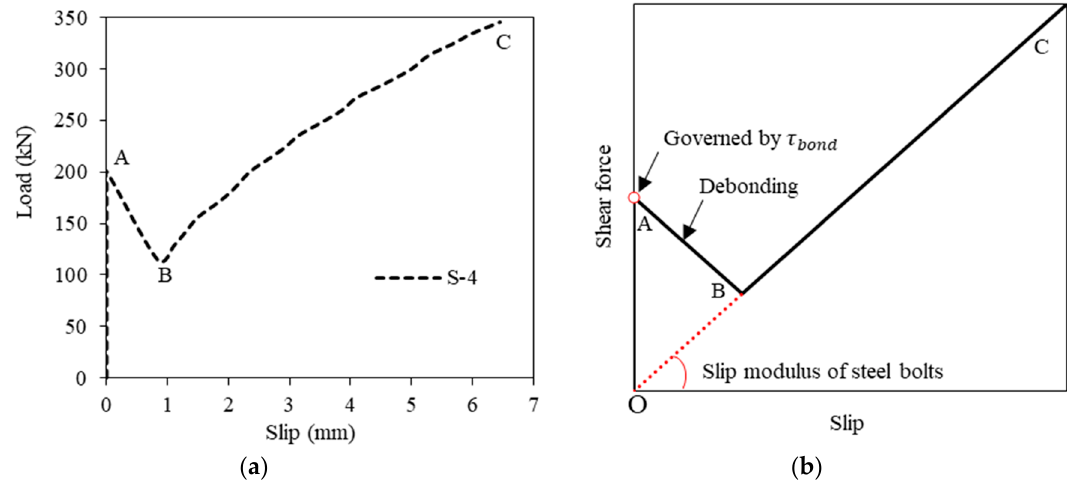
Figure 13. Simplification of the shear force-slip relationship for the steel bolts-SIP forms connection: ( a ) Measured curve for specimen S-4; and ( b ) Idealized curve. Appl. Sci. 2019 , 9 , x FOR PEER REVIEW